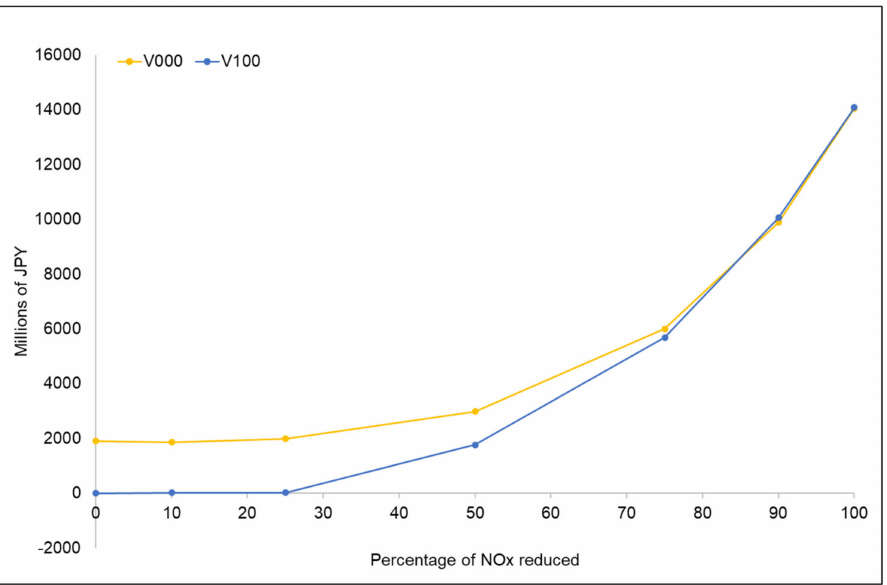
Figure 8. Crop production benefits measured as the economic change for the range of NO x reductions applied in the different evaluated